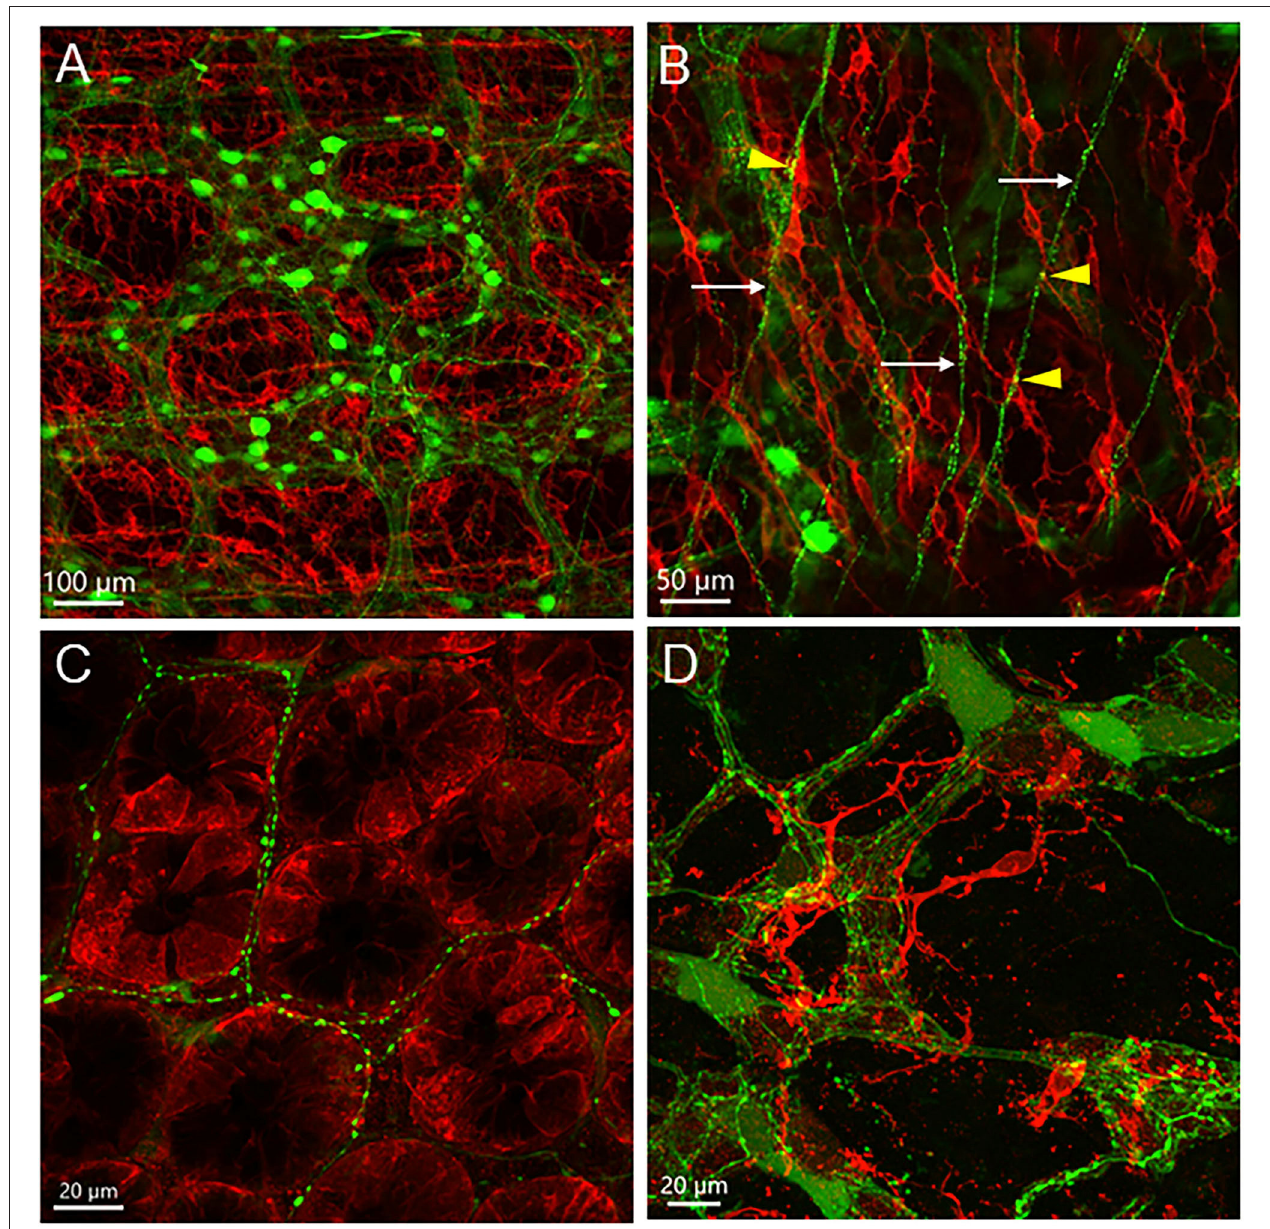
FIGURE 8 | c-Kit-immunofluorescent cells (red) in the mouse proximal colon with AAV9 transduction (green). AAV9-CAG-GFP was retro-orbitally injected at 3.3 x 10 11 GC/mouse 3 weeks before. (A) c-Kit-ir cells located near the myenteric plexus transduced by AAV9; (B) In the longitudinal muscle layer, not all of the c-Kit-ir elongated cells with processes were aligned parallelly to the projection of AAV9-transduced nerves (arrows); a few varicosities closely located to c-Kit-ir cells (yellow dots marked by arrowheads); (C) AAV9-transduced nerve fibers were distributed among c-Kit-ir cells in the base of the mucosal crypts; (D) c-Kit cells closely located to the submucosal plexus. Scales as indicated in each